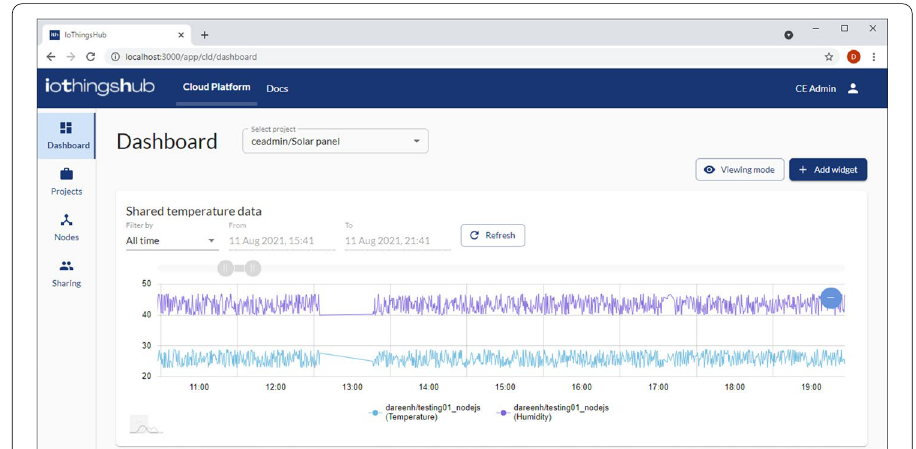
Fig. 16 IoThingsHub—displaying shared nodes data in local